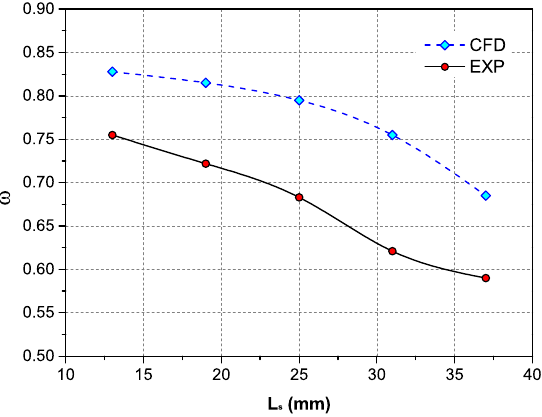
Figure 6. Comparison of predicted results and experimental data for ω with different L s .